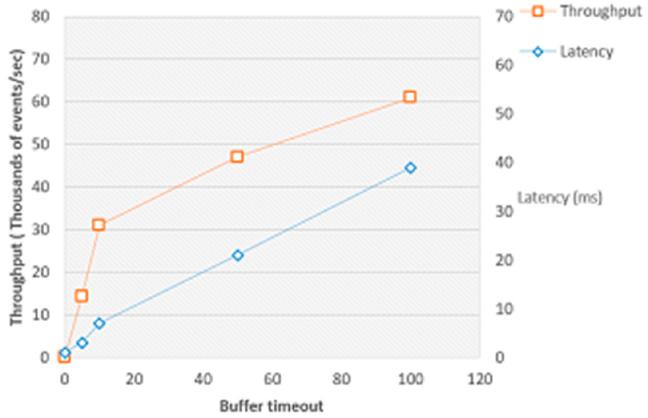
Figure 13. Throughput-latency tradeoff using varying task manager’s buffer timeout values (adapted from [12]).